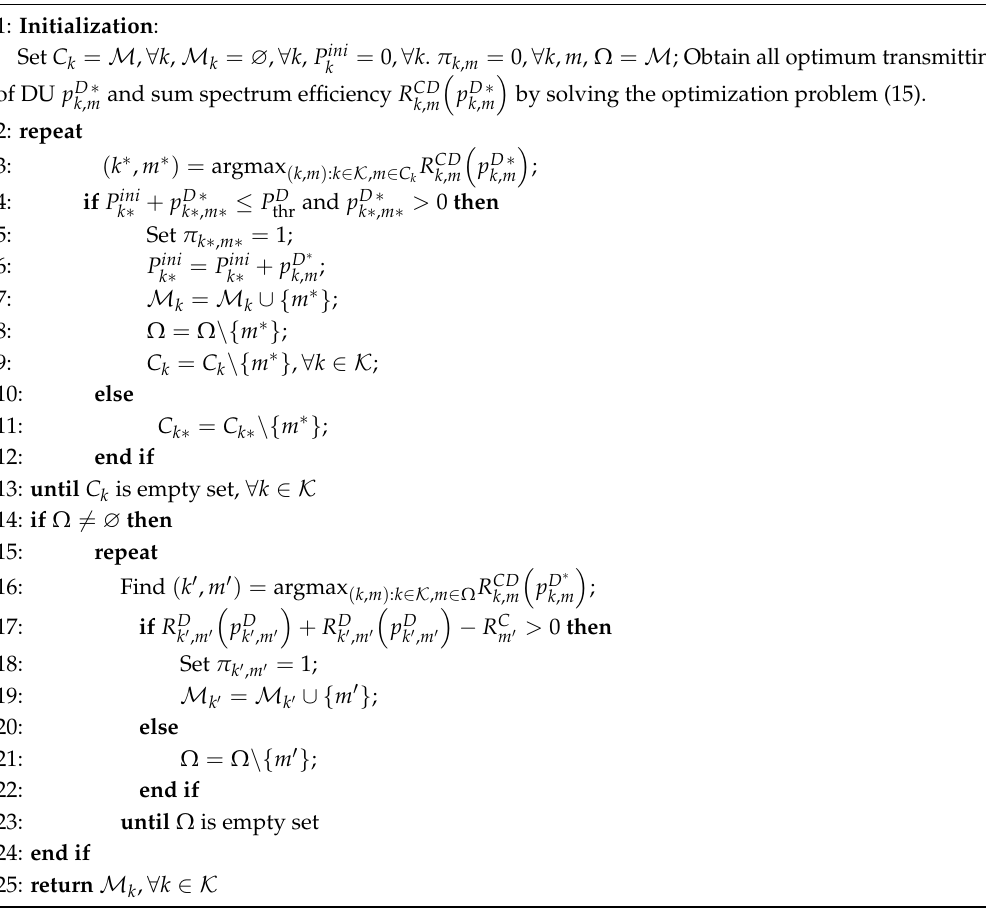
Algorithm 1. Greedy Algorithm for Subcarrier